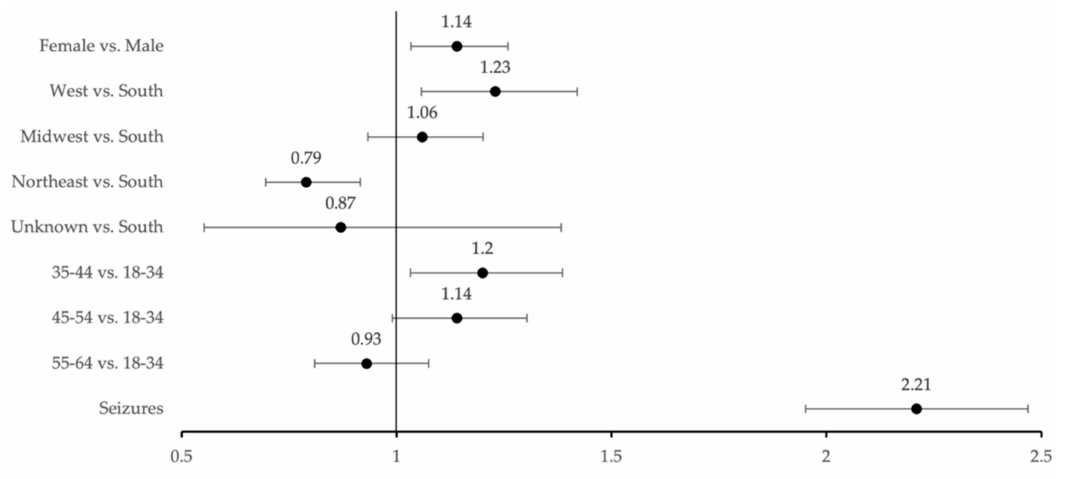
Figure 1. Risk factors associated with increased MHD incidence post-LGG diagnosis using unadjusted odds ratios with 95% Wald confidence